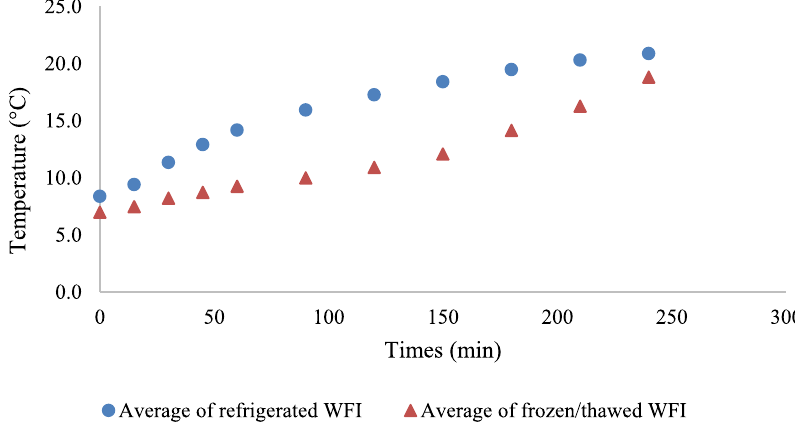
Figure 3: Evolution of temperatures of refrigerated WFI and frozen/thawed